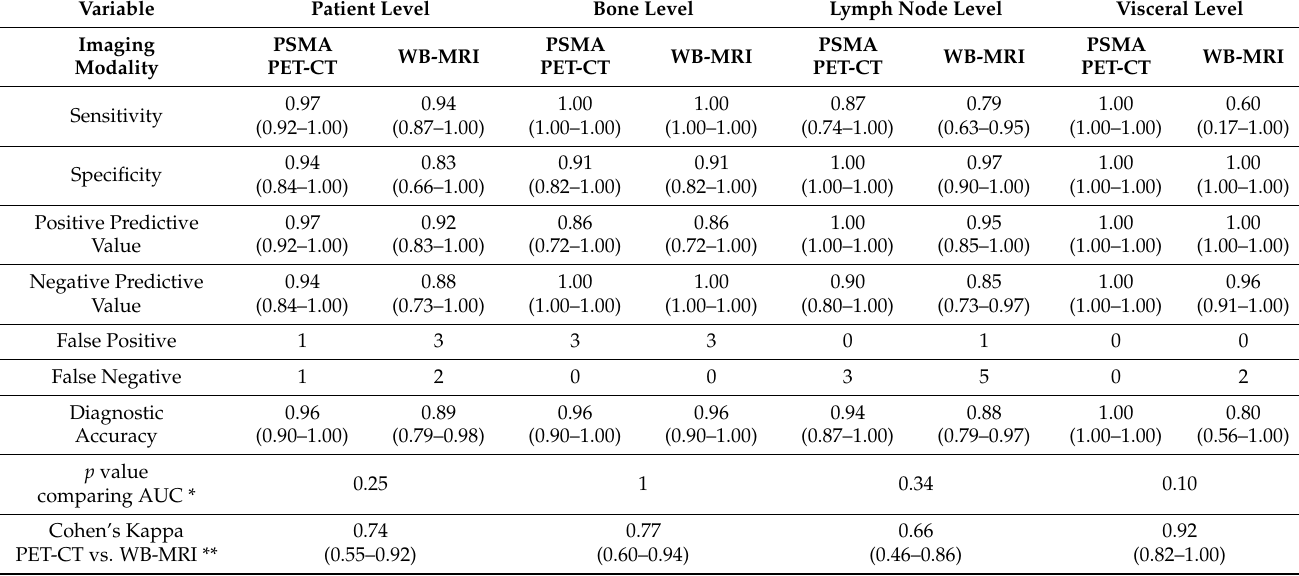
Table 5. Comparison of the diagnostic effectiveness of WB-MRI and PSMA PET-CT in 53 PCa patients at biochemical recurrence.